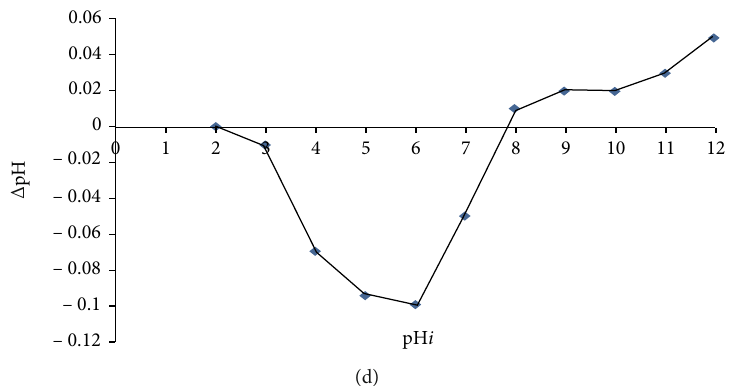
Figure 2: Characterization of the prepared CA/nZVI adsorbent (a) XRD, (b) SEM, (c) EDS, and (d) pH